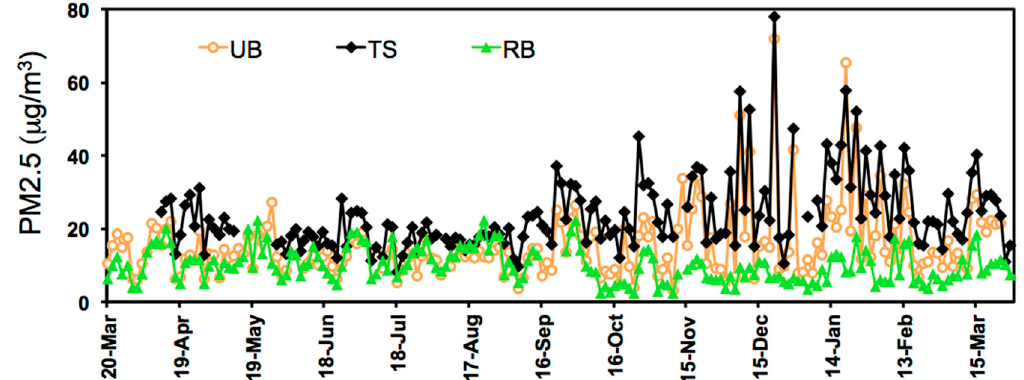
Figure 1. Particulate matter (PM) 2.5 daily mass concentrations at the traffic site (TS), urban background site (UB) and rural background site (RB) sampling sites (uncertainties, which are not reported for clarity sake, are of the order of few μ g·m − 3 ).